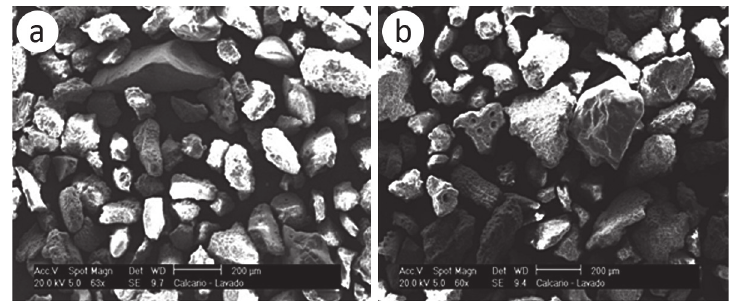
Fig. 3 - SEM micrographs of the limestone powder particles: magnifications of (a) 63 times and (b) 60 times.